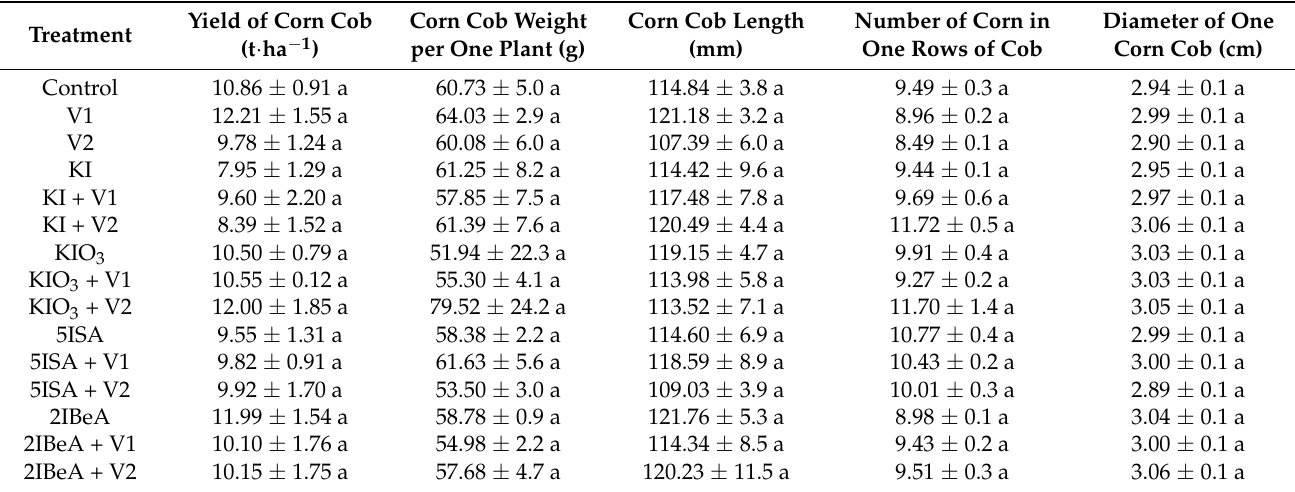
Table 1. Results of yield of corn cob, corn cob weight per one plant, corn cob length, number of corn kernels in one row of cob and diameter of one corn cob in experiment No.